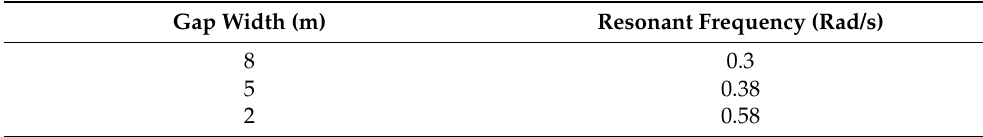
Table 1. Effect of gap width between the barges on resonant